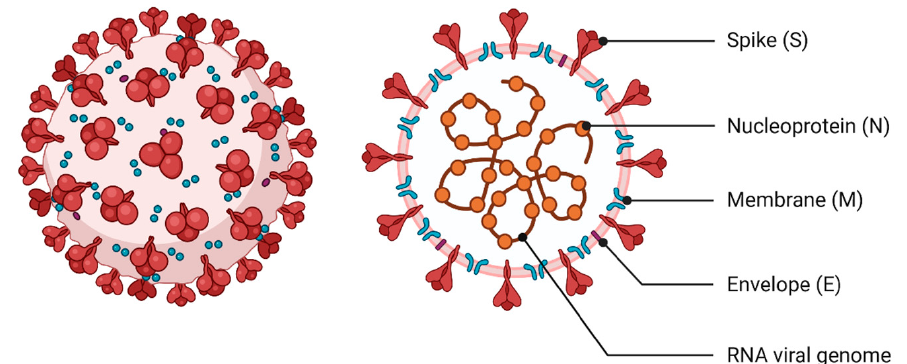
Figure 1. Human SARS-CoV-2 structure. SARS-CoV-2 is composed of 4 structural proteins: mem- brane protein (M), spike protein (S), envelope protein (E) and nucleoprotein (N), which is responsible for the formation of the capsid. The genetic material of SARS-CoV-2 is a single-stranded positive- sense RNA. Created with BioRender.com (accessed on 8 May 2021).